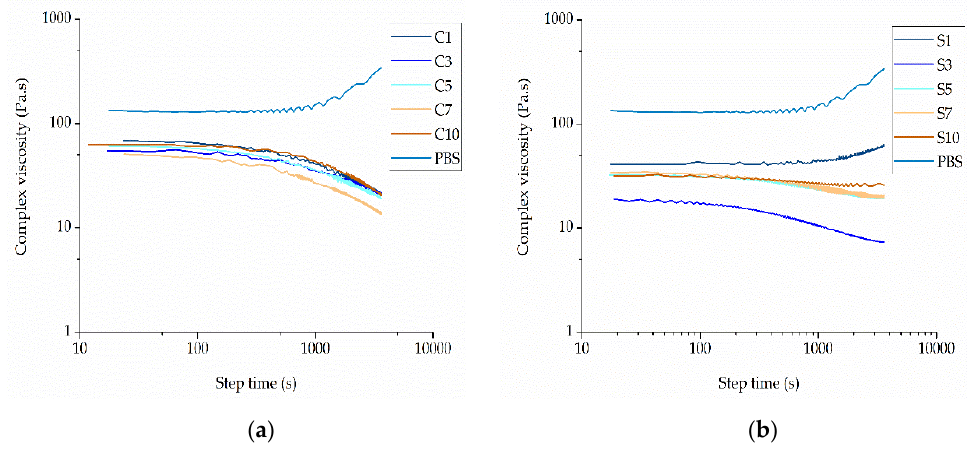
Figure 13. Rheogram showing the complex viscosity of ( a ) PBS-curcumin compounds and ( b ) PBS- silver compounds with increasing step time at 235 °C.